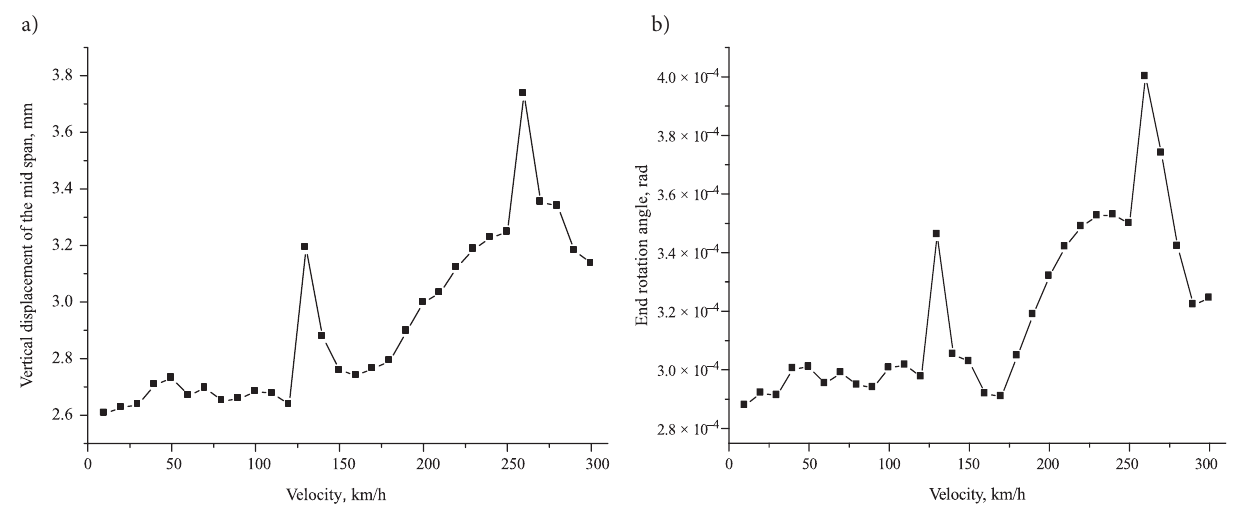
Fig. 7. Model bridge responses with the different train speed spectrum: a – vertical displacement; b – end